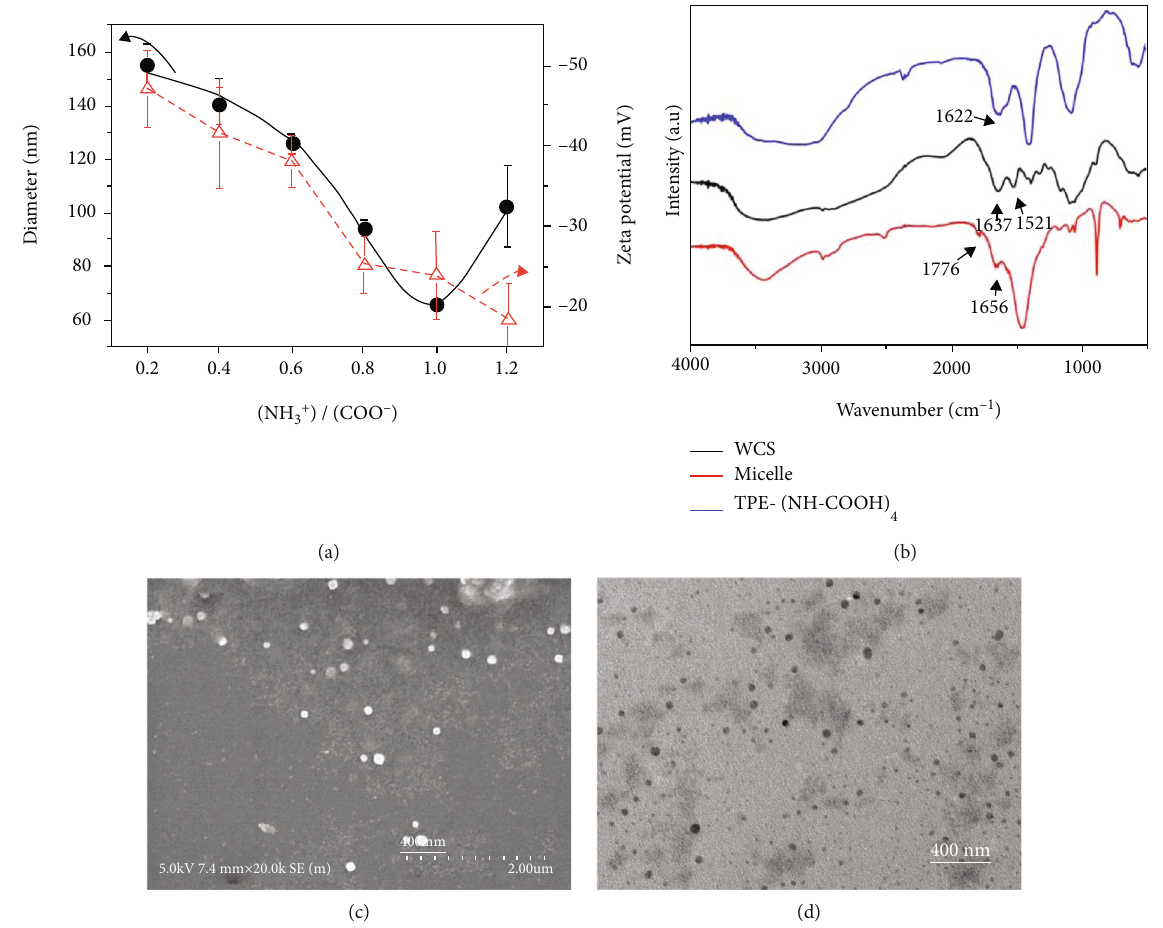
Figure 2: (a) The average hydrodynamic diameters and zeta potential of micelles as a function of [NH 3+ ]/[COO - ] ratio upon mixing WCS and TPE-(N-COOH) at pH = 8 . (b) FT-IR spectra of WCS, TPE-(N-COOH) 4 the micelles with charge ratio (+/-) of